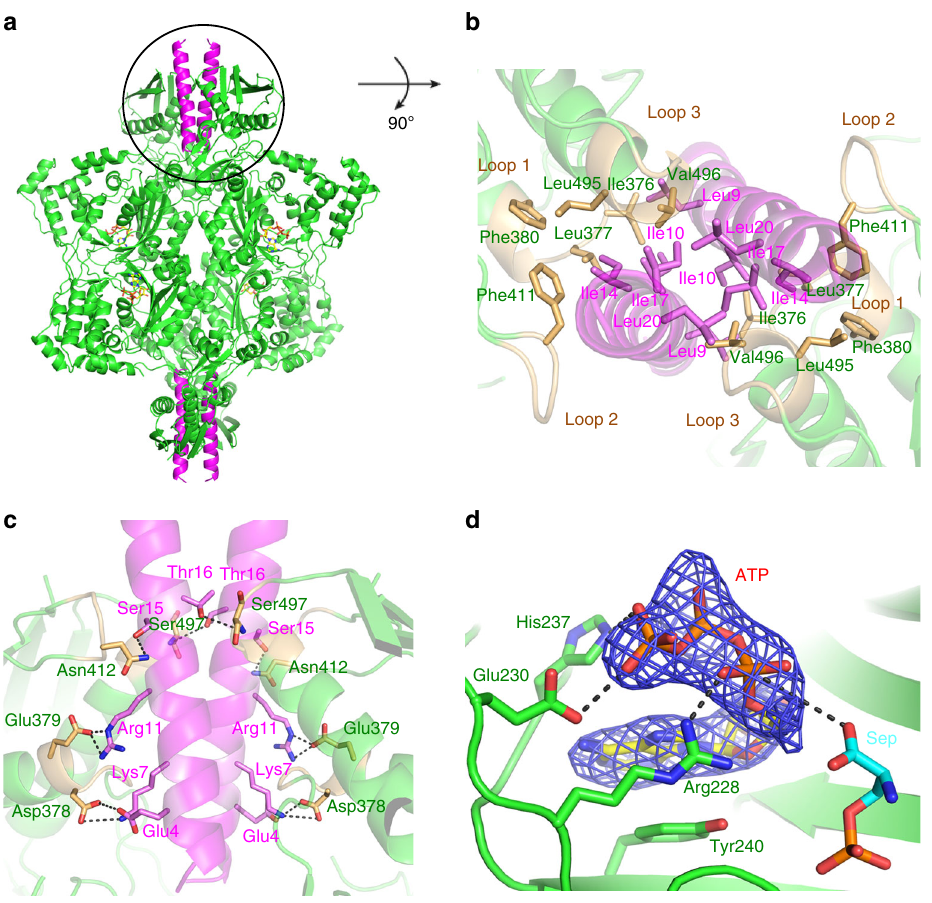
Fig. 2 Structure of SepRS in complex with SepCysE. a A pair of N-terminal helices (N-helices; (Met1-Lys24)) of the dimeric SepCysE (magenta) wound around each other to form a coiled-coil structure and was tightly bound to the SepRS dimer (green) with their two-fold axes aligned in parallel. ATP in each active site is shown in stick model. b Hydrophobic residues of both SepRS and SepCysE contribute to the tight complex formation. c Hydrogen bonds also exist between SepRS and the N-terminal helices of SepCysE contributing to the stability of the complex. d Bent ATP superposed with Fo-Fc omit electron density map contoured at the 2 σ level (blue). Arg228, Glu230, His237 and Tyr240 in the active site of SepRS interact with ATP, which adopts a bent conformation conserved in class II aaRSs. Superposition of Sep from SepRS-Sep complex (PDB:2DU3) showed Sep locates next to ATP, with OH group in the reach of α phosphate of ATP to form